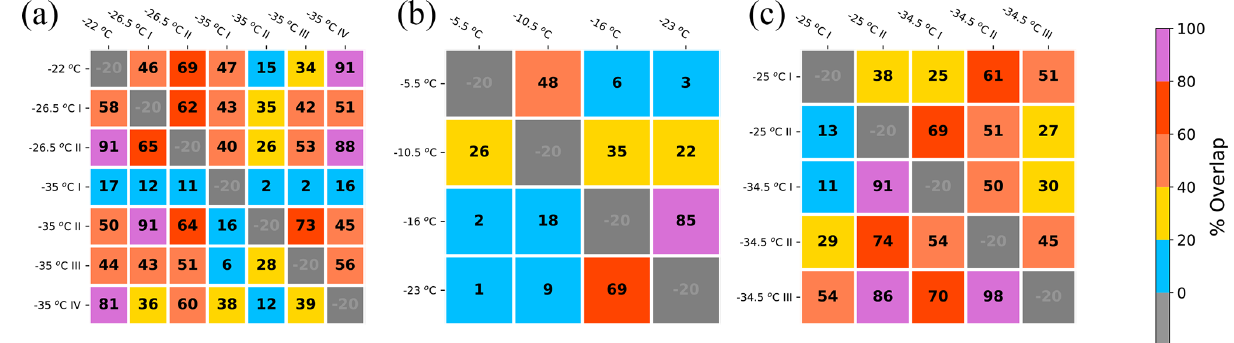
Figure 9. Matrix of overlap area between the equally plausible ( a,b ) surfaces corresponding to each row and column for (a) 25 April, (b) 20 May, and (c) 23 May 2011. The overlap area for each square is normalized by the area of the ( a,b ) surface corresponding to the flight leg listed in each